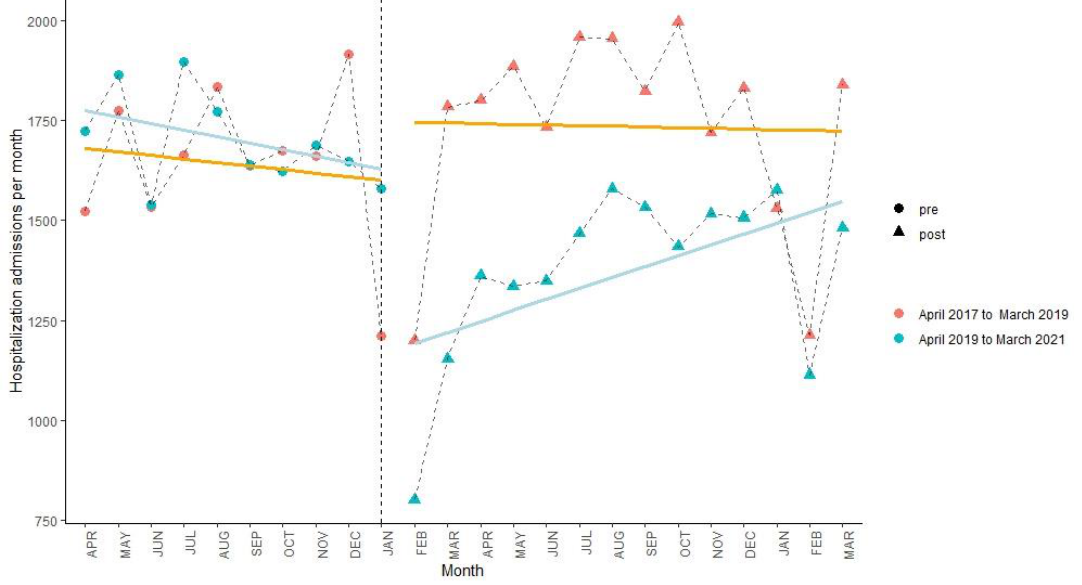
Figure 3. Interrupted time series analysis of hospital visits outside Yangxi County but still within Yangjiang City from April 2017 to March 2019 (orange line) and from April 2019 to March 2021 (blue line). The line is the model fit and the vertical dashed line indicates the intervention (23 January 2020).